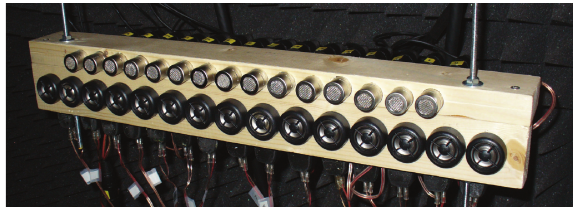
Figure 2: Transmitter and receiver arrays.